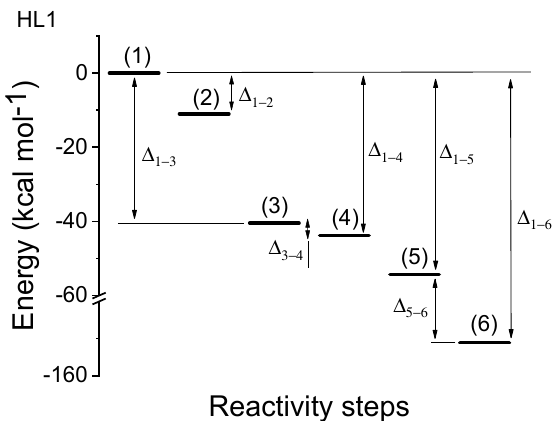
Figure 3. Potential energy surface (PES) for the elementary reactions yielding the composite catalyst: 1 to 5 (Cat1). Energy difference 6 corresponds to the catalyst/oxygen interaction, in the case of the HL1 supramolecular catalyst, UHF PM6 level of theory (compare Table 1 and Results and Discus-